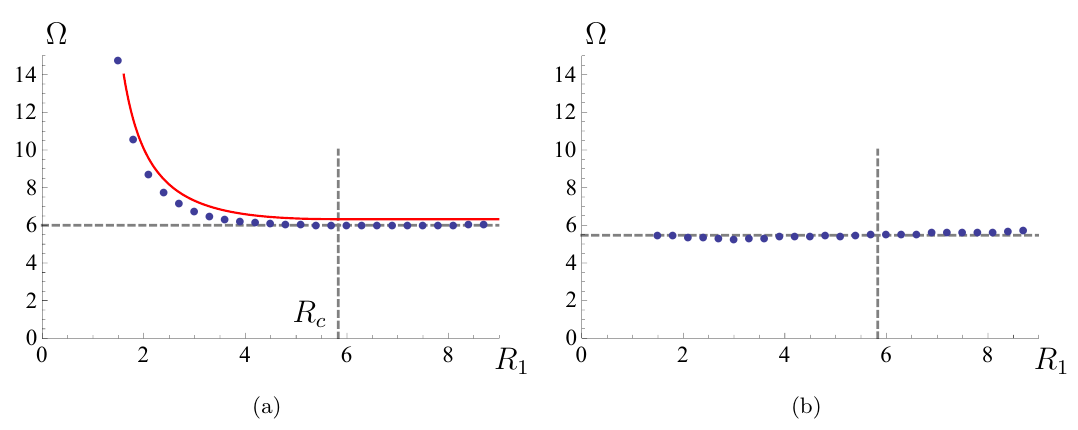
Figure 8 . The exponent in (3.30) extracted from numerical. The parameters take the same values as in (cid:12)gure 7: (a) The Gross-Ooguri transition is clearly visible for opposite-orientation loops. It is clear from the plot that the transition is second order. The red curve corresponds to the analytical result for (3.20) and (3.26) and the di(cid:11)erence with the numerical is attributed to (cid:12)nite g e(cid:11)ects;